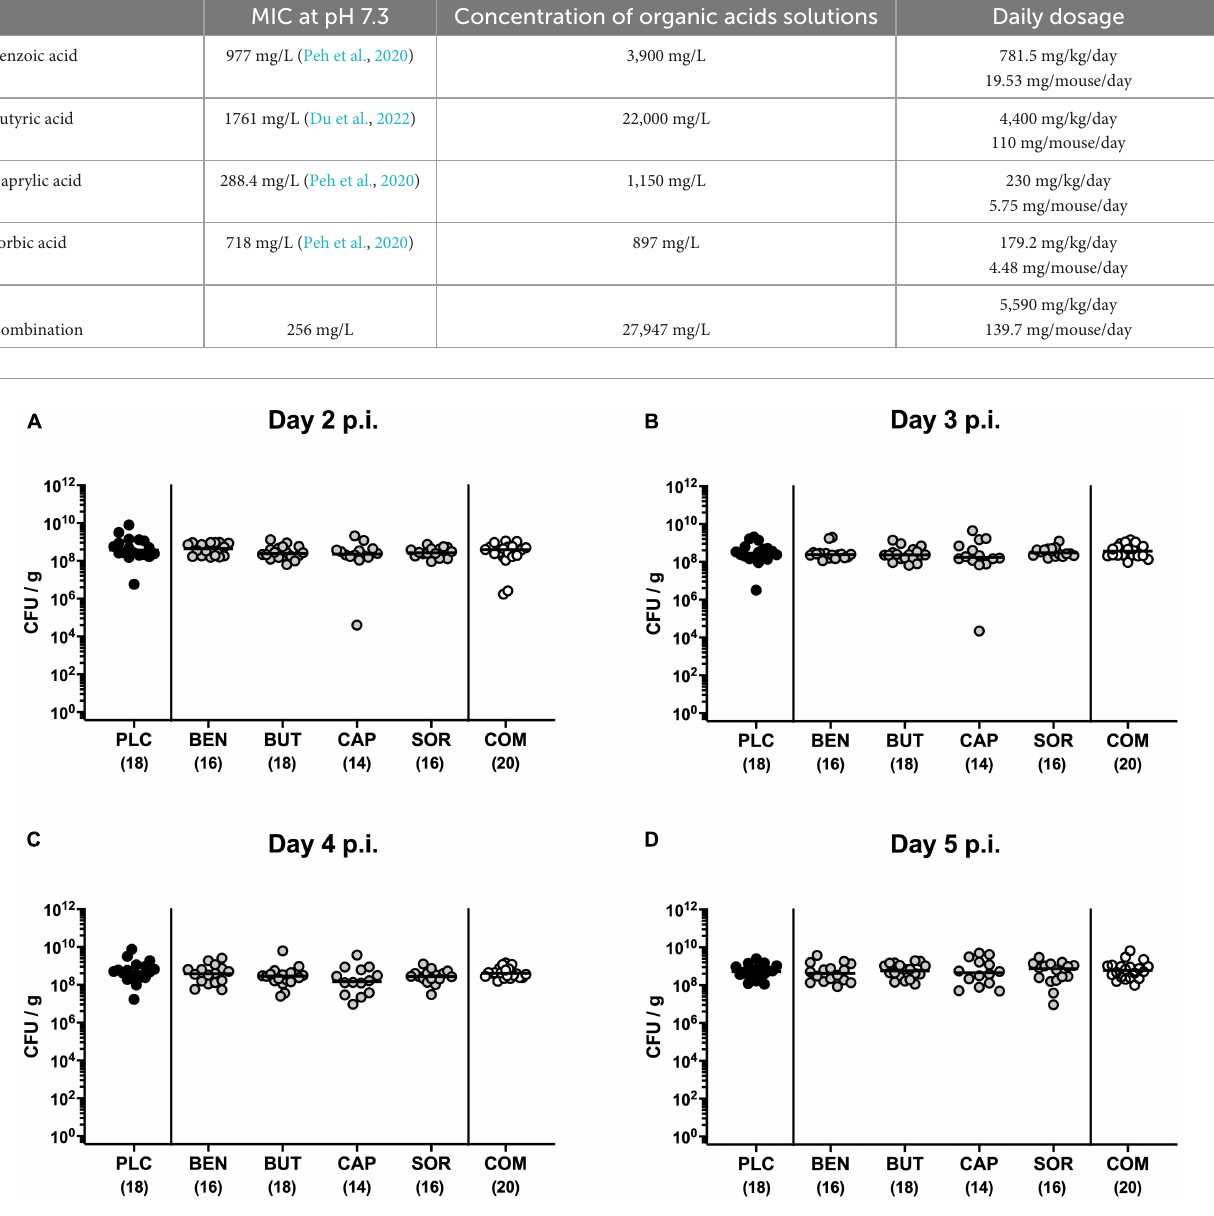
FIGURE1 Kinetic survey of pathogen loads post-infection upon single and combined organic acid treatment of C. jejuni infected IL-10 − / − mice. Secondary abiotic (SAB) IL-10 − / − mice were perorally infected with C. jejuni strain 81-176 on days 0 and 1. Starting on day 2 post-infection (p.i.), the mice were treated with benzoic acid (BEN), butyric acid (BUT), caprylic acid (CAP), sorbic acid (SOR), or a combination (COM) of respective organic acids via the drinking water for 4 days. The placebo (PLC) group only received autoclaved tap water. The pathogen loads were quantified on (A) day 2, (B) day 3, (C) day 4, and (D) day 5 p.i. by culture (colony forming units per gram; CFU/g). Medians (black bars) and total mice numbers (in parentheses) are indicated. Data were pooled from three independent